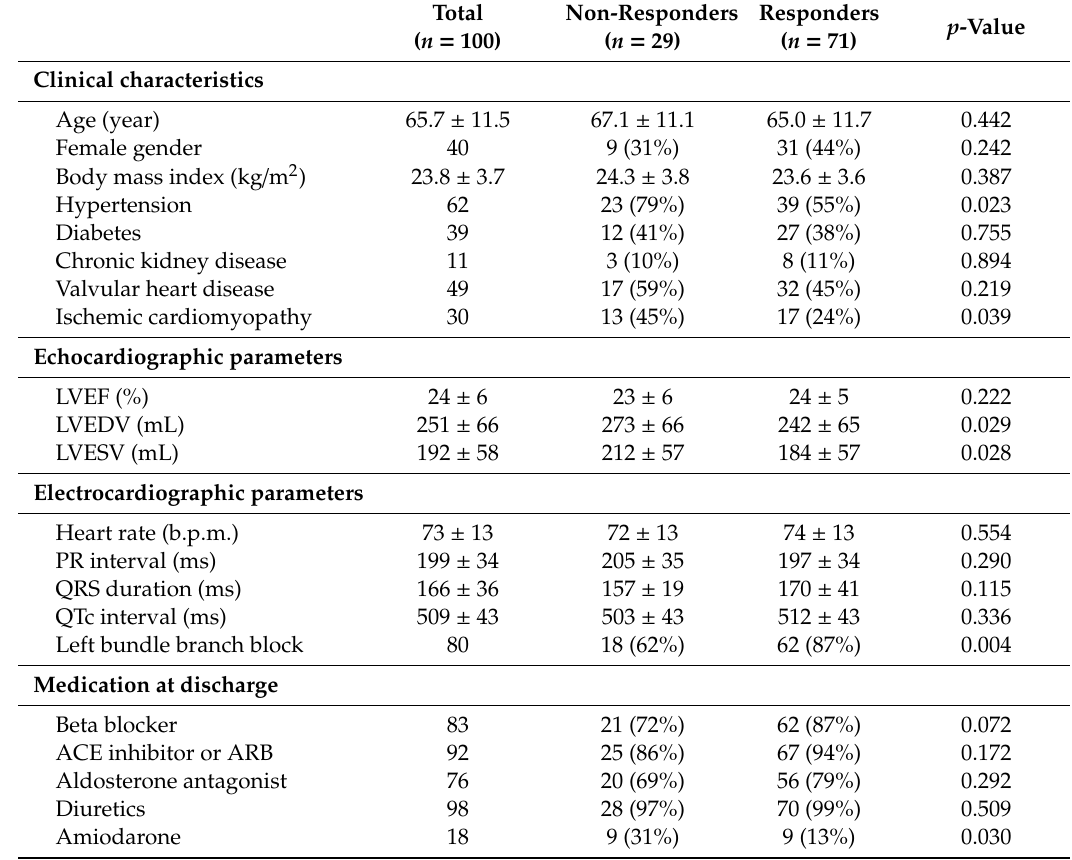
Figure 2. Changes in the native QRS duration ( A ) and PR interval ( B ) according to the degree of cardiac resynchronization therapy (CRT) response.